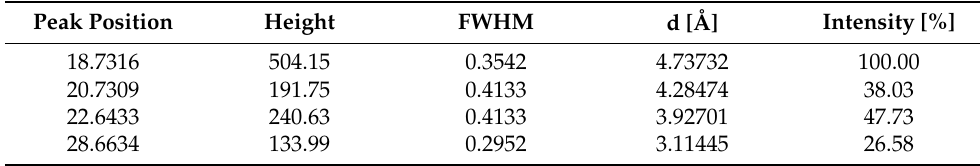
Figure 6. X ‐ ray diffraction patterns of PEEK before and after electron beam irradiation. Figure 6. X-ray diffraction patterns of PEEK before and after electron beam irradiation. Table 3. Basic diffraction spectral parameters of pristine PEEK. Table 3. Basic diffraction spectral parameters of pristine PEEK.